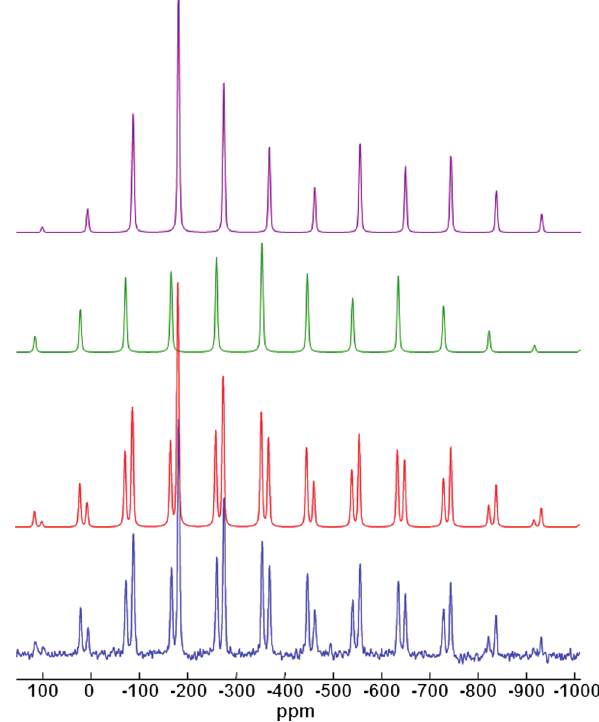
. Figure 7 119 Sn MAS NMR spectrum of Sn(PyS) 2 Signal traces are as follows (from top): simulated signal 1 (purple), simulated signal 2 (green), simulated spectrum with signals 1 and 2 (red), and experimental spectrum (blue). The characteristics of the chemical shift anisotropy tensors are as follows: for signal 1, δ iso -368.2 ppm, δ -57.1 ppm, δ -112.2 ppm, δ -935.3 ppm, Ω 878.2 11 22 33 ppm, κ 0.87; for signal 2, δ -353.0 ppm, δ 110.0 ppm, δ -315.1 iso 11 22 ppm, δ -853.9 ppm, Ω 963.8 ppm, κ 33